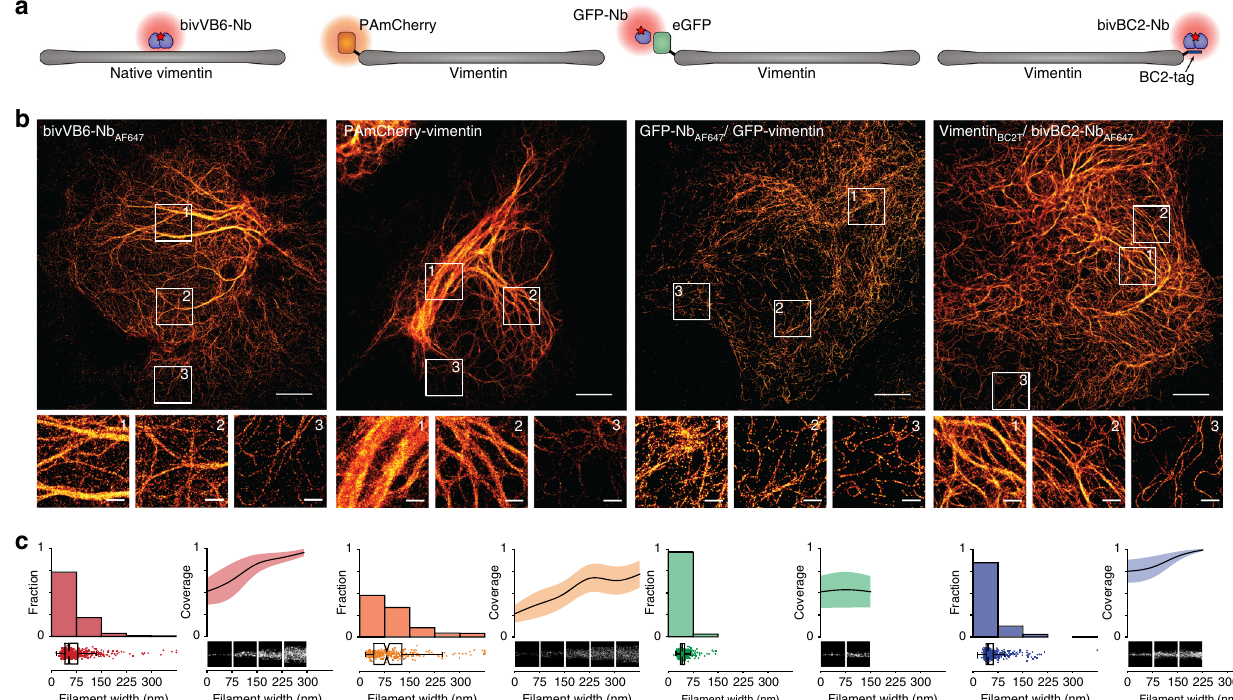
Fig. 2 Super-resolution imaging and analysis of differently labeled vimentin constructs. a Schematic illustration of labeling strategies used for comparative SRM imaging of native or ectopically expressed vimentin. b Representative PALM/dSTORM images of chemically fi xed Hela cells expressing the corresponding constructs outlined in a or native vimentin (left panel). Insets show magni fi cations of representative vimentin fi laments of varying thickness (1 — thick, 2 — medium, 3 — thin, peripheral). Scale bars, 5 µ m in main images, 1 µ m in insets. c Filament widths as histograms (left) with a bin size of 75 nm ( x -axis) plotted against relative fraction ( y- axis). Full data are represented underneath the histograms as box + scatter plots with the same x- axis. The box marks the three quartiles and the whiskers mark 95% of all the data. The average lengthwise fl uorophore coverage was calculated for each bin and plotted (right) as mean fi lament width (black line) and standard deviation (colored area) against relative fraction covered by fl uorophores ( y -axis). Width and lengthwise fl uorophore coverage were analyzed for a total of 676 (bivVB6-Nb AF647 ), 295 (PAmCherry), 724 (GFP-Nb AF647 ), and 620 (bivBC2-Nb AF647 ) fi laments, N = 5 cells for each condition, cells, and selected fi laments are shown in Supplementary Fig. 4. Image reconstruction details are given in